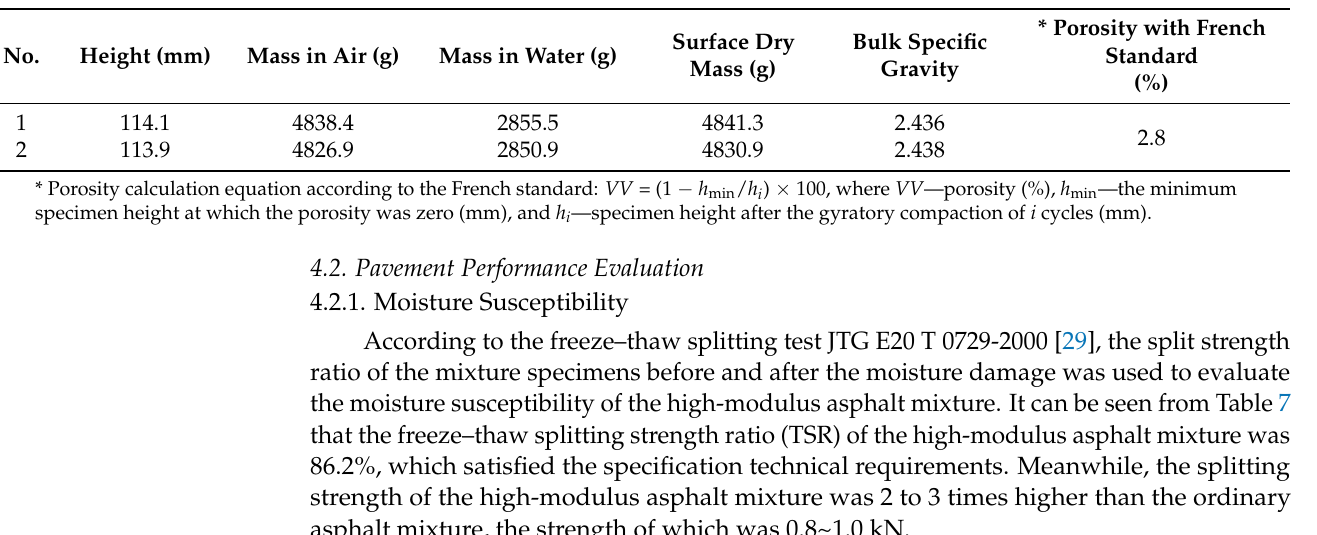
Table 6. Results of the gyratory compaction test (100 cycles).